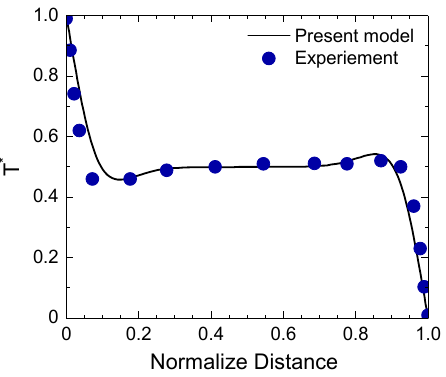
Figure 6. The comparison between present model and experimental data for normalized temperature with normalized distance. The experimental data are taken from Ref. [57].